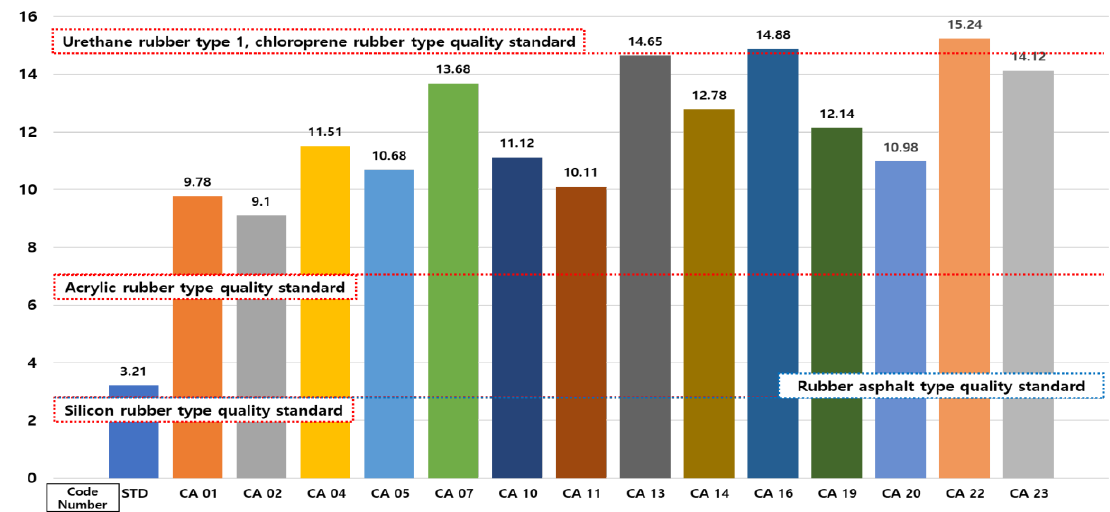
Figure 18. Comparison of composite additive tear strength test results and quality standards.